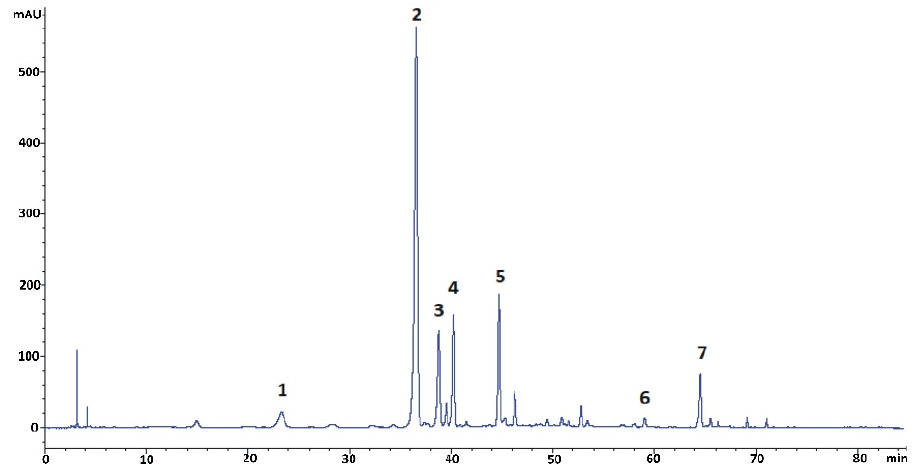
Figure 1. RP-LC/PDA chromatogram (registered at 260 nm) of isoflavonoids found in the kudzu root lyophilisate. Compounds: 1 = 3 ′ -hydroxypuerarin; 2 = puerarin; 3 = 3 ′ -methoxypuerarin; 4 = mirificin; 5 = daidzin; 6 = ononin; 7 = formononetin.